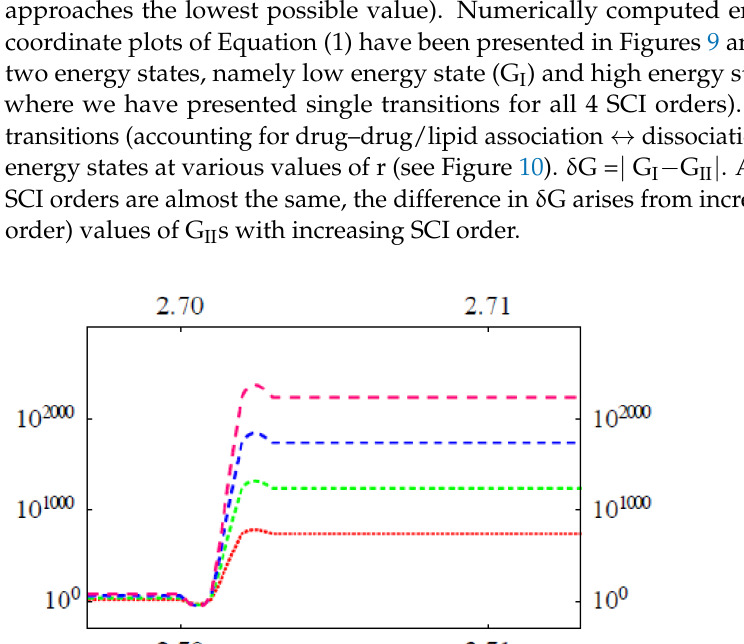
Figure 9. Numerically computed scale free energy versus reaction coordinate r plots of Equation (1). Col in Col cluster (top panel) and Col in lipid (e.g., PC) cluster (bottom panel). In both panel figures there are 4 curves representing energies of four SCI orders first, second, third, fourth (bottom to top). Here a = 1 nm, q Col q PC = 10 − 2 e 2 , as PC is nearly charge neutral, but MAAs are negatively charged in physiological aqueous phase (see [44]). e is the electron charge.